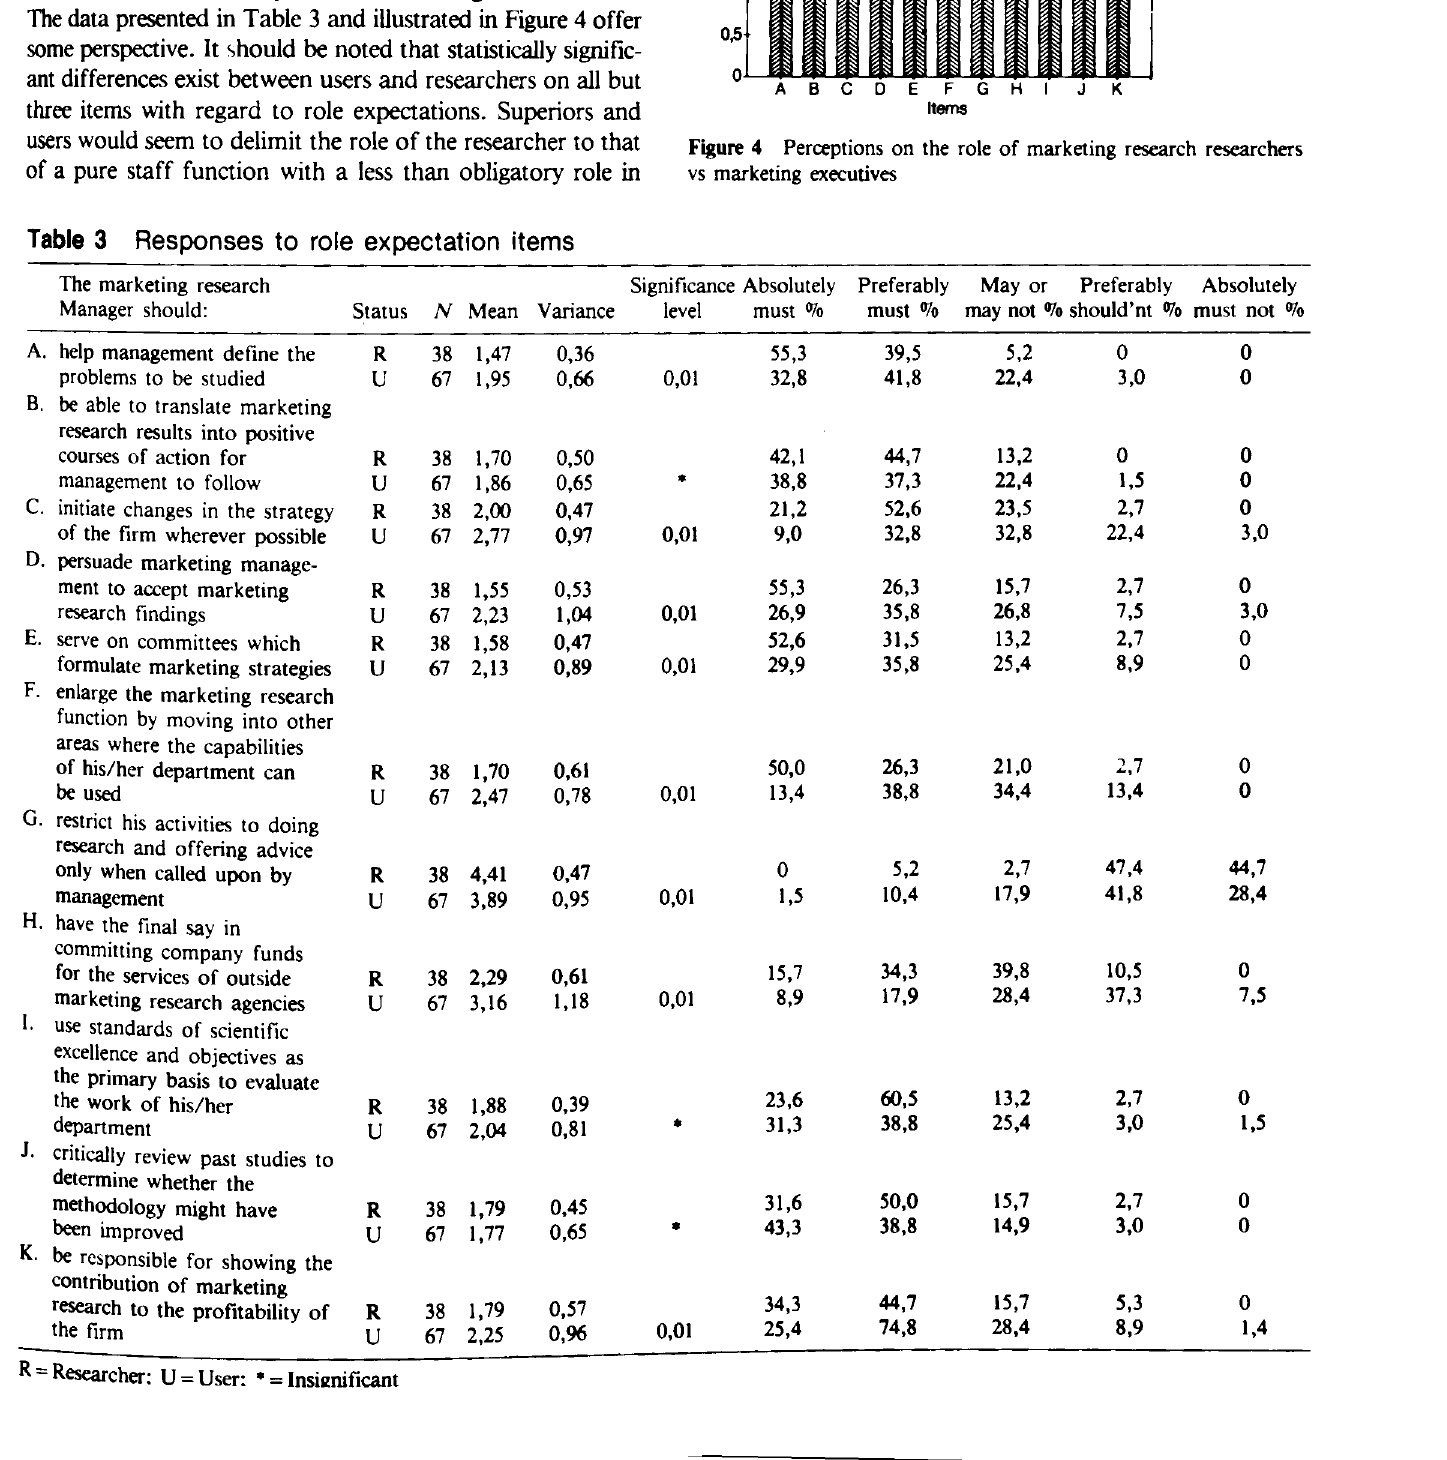
Figure 4 Perceptions on the role of marketing research researchers vs marketing